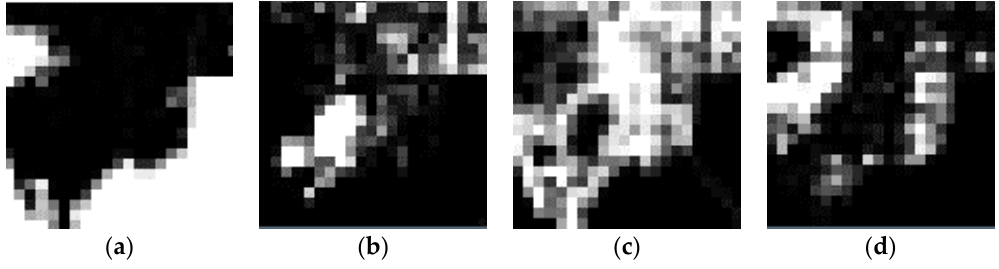
Figure 10. Proportion images produced by the LMM_SE model from the 2009 MODIS image. ( a ); ( b ); ( c ) and ( d ) correspond to water, vegetation, urban city, and built-up areas, respectively. Remote Sens. 2017 , 9 , 284